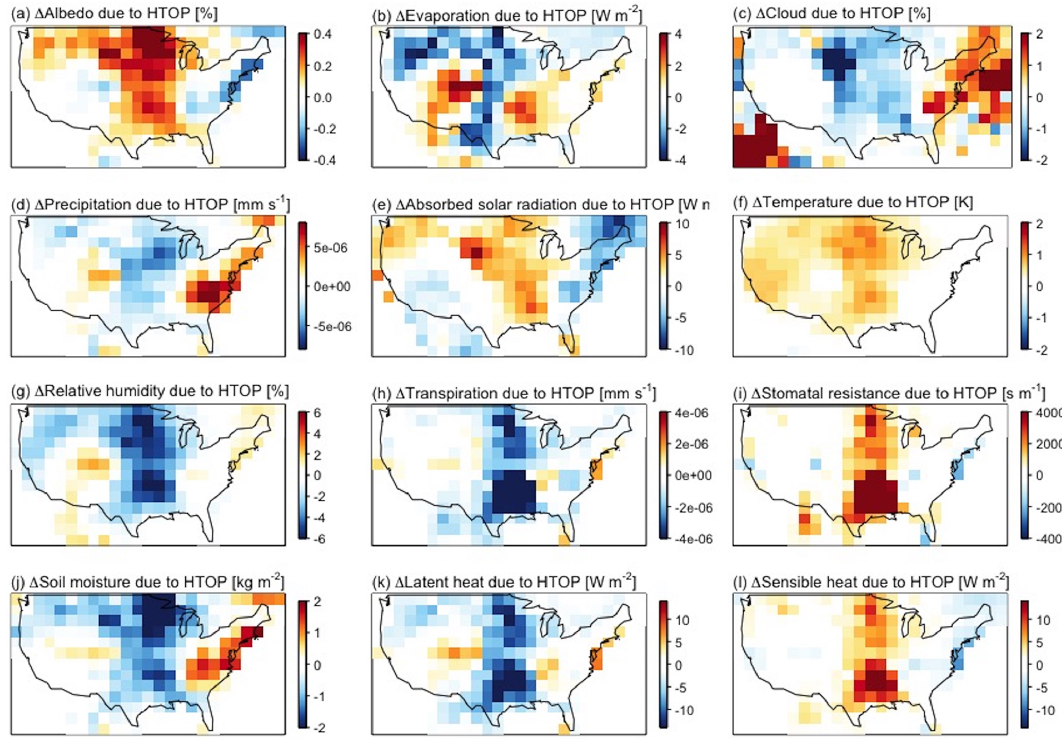
Figure 8. Same as Fig. 7 but driven by canopy height